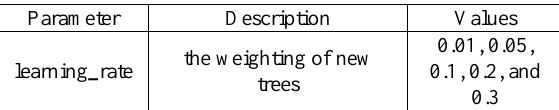
Table 1 . Parameters for hyperparameter tuning of Xgboost regression model in R software.